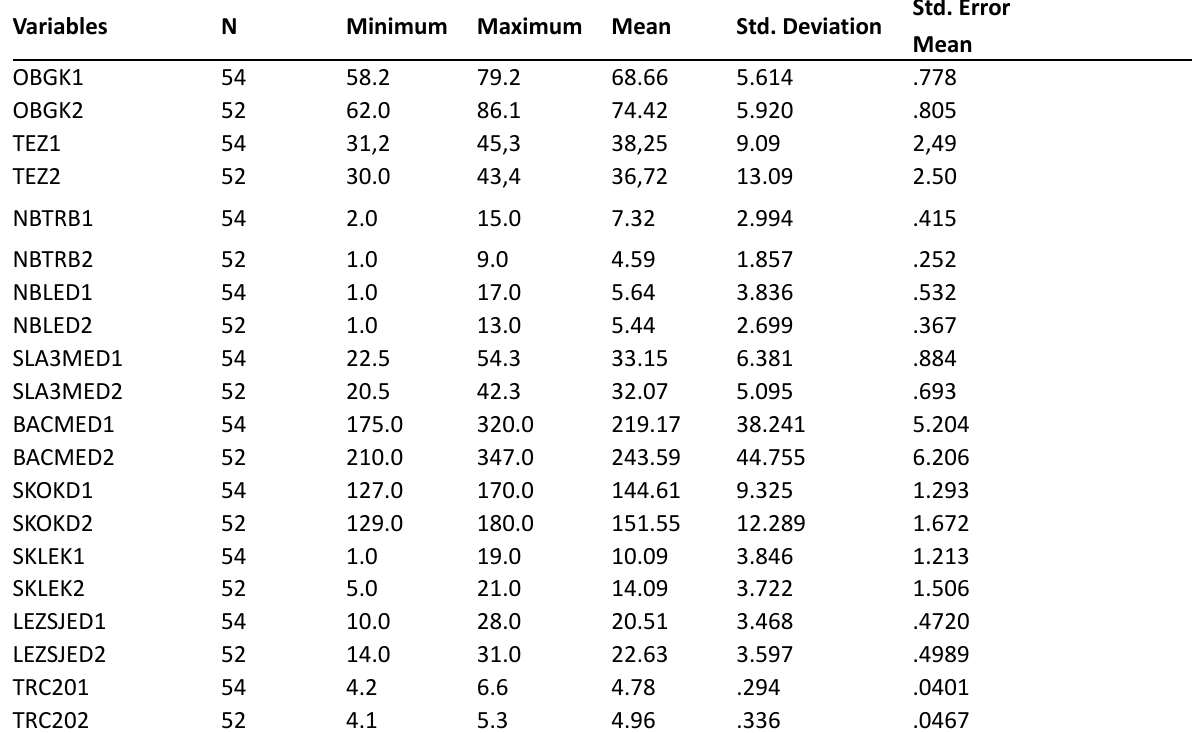
Table 1. Descriptive Statistics Variables